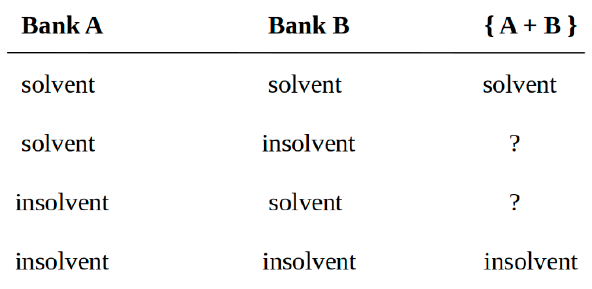
Figure 1. Bank mergers and bank solvency.